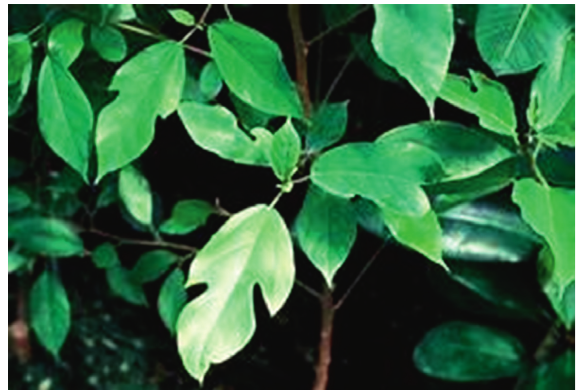
Figure 3: Ficus exasperata leaf before drying